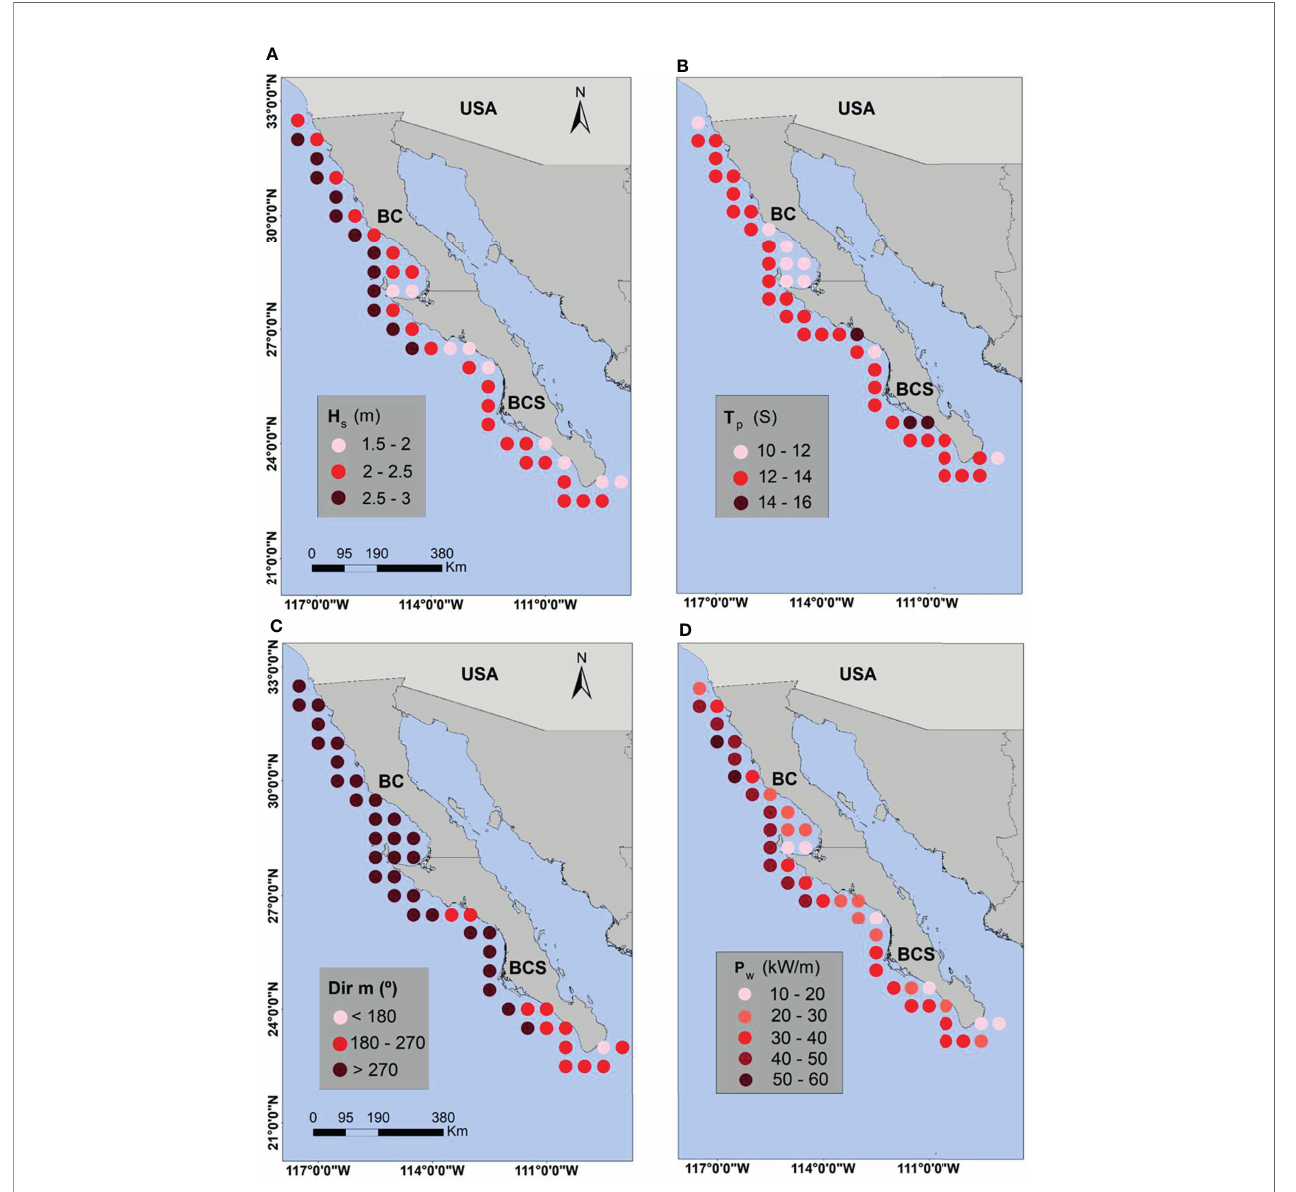
FIGURE 4 | Annual averages of storm wave parameters: (A) Signi fi cant wave height, (B) Peak period; (C) Mean direction; (D) Wave energy